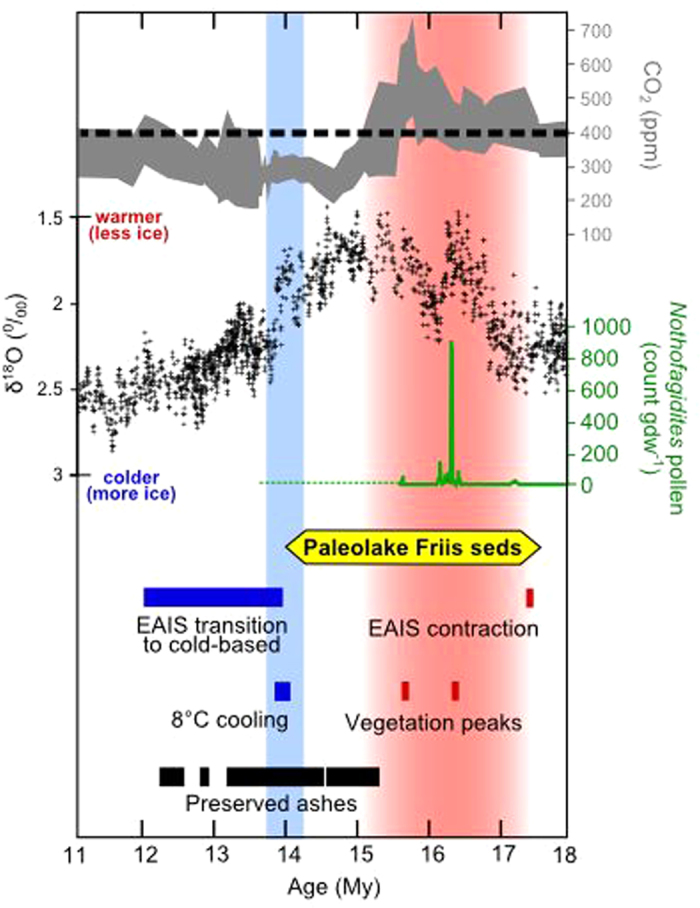
Modeled age range of Paleolake Friis sediments (14.0 to 17.5 My) and global and regional paleoclimatic indicators throughout the middle Miocene.In red: the MMCO defined globally ~15–17 My24 and regionally 15.4–17.6 My25. In blue: the MMCT, 13.8–14.2 My29. Labeled events include: the onset of EAIS contraction, 17.21–17.49 My35; peaks in vegetation expansion (including terrestrial tundra taxa and marine and freshwater algae species) centered on 15.7 and 16.4 My27; the range of ages of pristinely preserved ashes (measurement error included in bar width)5628; 8 °C cooling on Antarctica8; EAIS transition to cold-based 12–14 My prior to major expansion at ~12 My824. Black crosses: global δ18O record (0/00), five point smooth24. Grey shading: global atmospheric CO2 (ppm) reconstruction, 5 point smooth9. Green line: Nothofagidites (type Nothofagus fusca) pollen abundance (count per grams dry weight, gdw−1) measured in AND-2A core27. The pollen abundance peak ~16.4 My is further evidence that Nothofagus, those leaf fossils in Paleolake Friis sediments, existed on Antarctica during the MMCO. The dotted green line represents a sedimentary hiatus in the AND-2A core that is attributed to ice sheet growth.